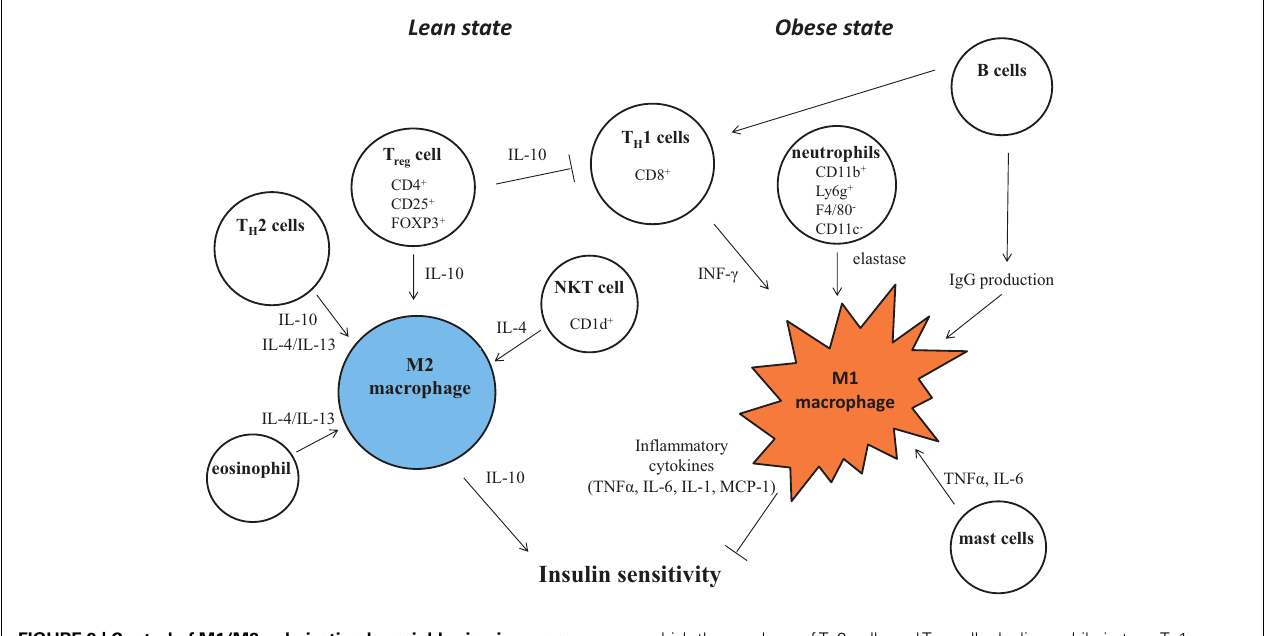
FIGURE 3 | Control of M1/M2 polarization by neighboring immune cells . In a lean state, residentT cells consist ofT H 2 cells,T reg cells, and NKT cells. Combined with resident eosinophils, these cells sustain the M2 activation of macrophages through secreting IL-4, IL-10, and IL-13. As obesity progresses, alteration of constituent immune cells occurs, in